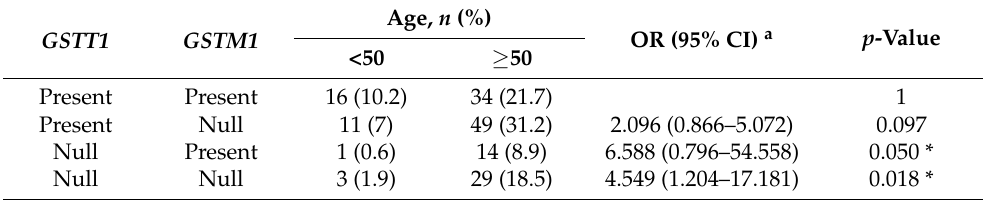
Table 3. Association between GSTT1 and GSTM1 genotypes combination and patient age at diagnosis of breast cancer.